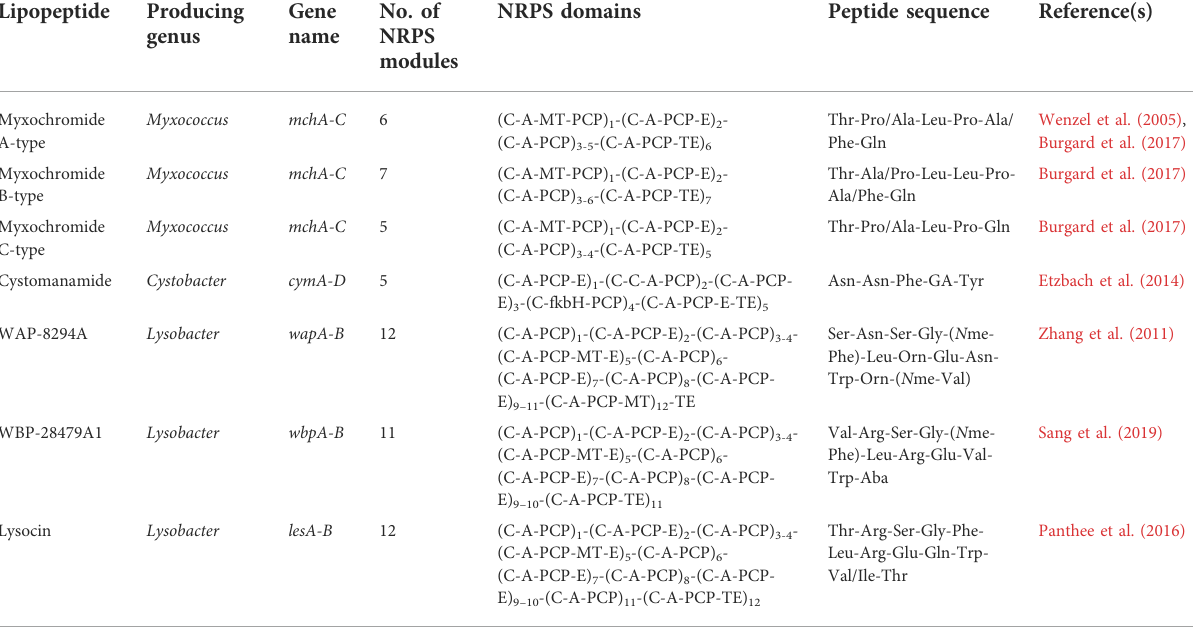
TABLE 2 Summary of the known PKS-NRPS BGCs identi fi ed from Myxococcus , Cystobacter and Lysobacter species.